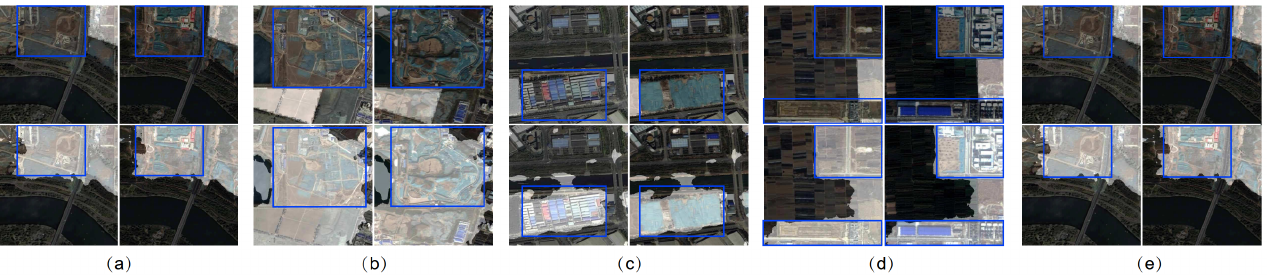
Figure 8. Samples of argued detection patterns (a–e). The missing labeled urban-construction-related change areas are bounded by the blue